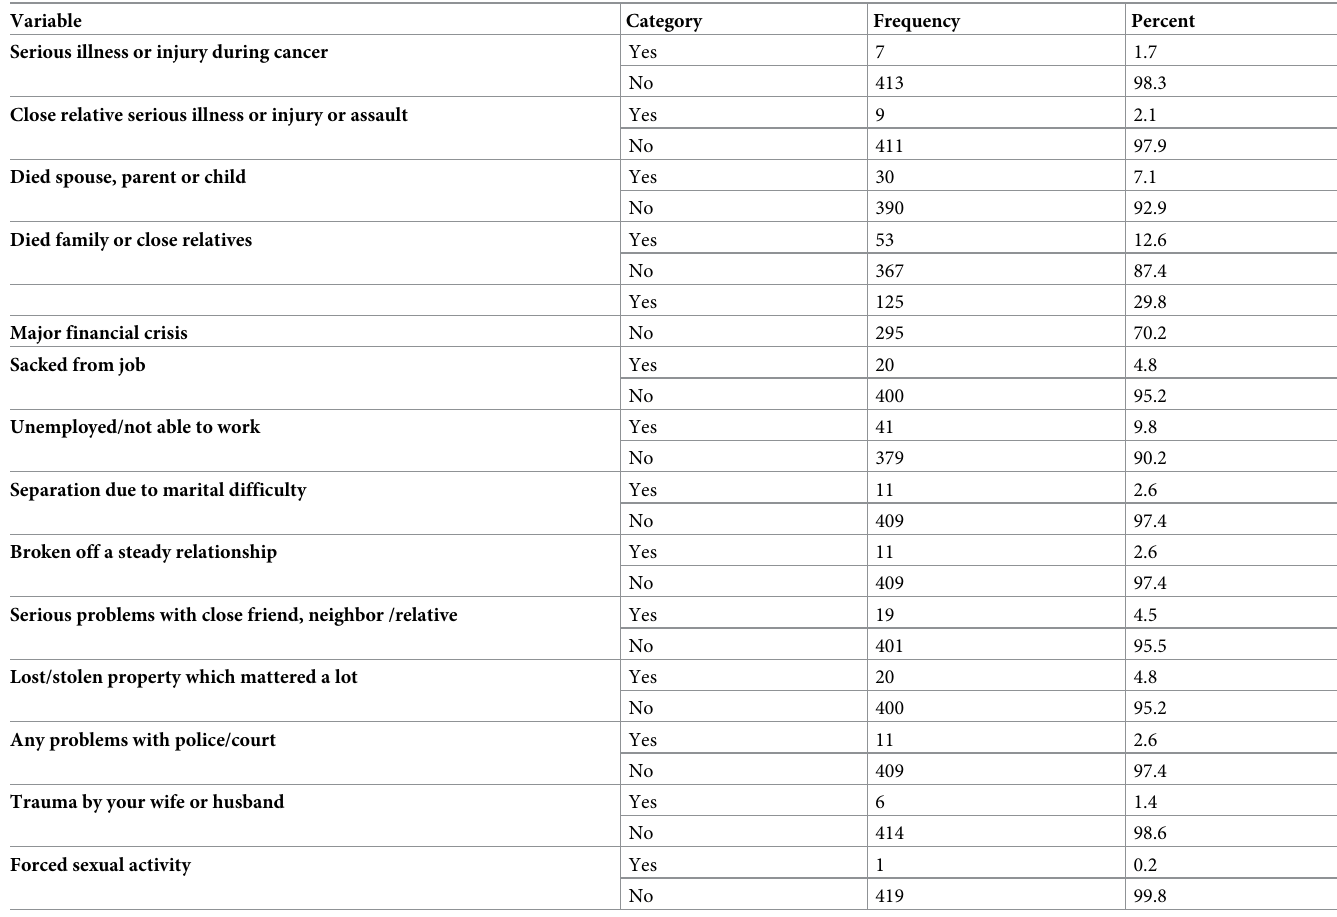
Table 3. Psychosocial factors (in the last 6 months) of adult cancer patients receiving chemotherapy at TASH, Addis Ababa, Ethiopia,